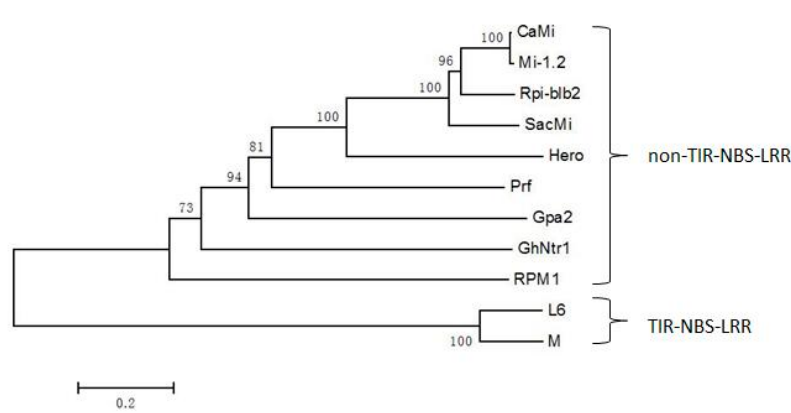
Figure 3. Phylogenetic relationships between SacMi and Mi-1.2 (AAC67238.1), CaMi (ABE68835.1), Prf (AAC49408.1), Hero (CAD29729.1), RPM1 (AGC12590.1), Rpi-blb2 (AAZ95005.1), Gpa2 (AAF04603.1), GhNTR1 (AIR09519.1), L6 (AAA91022.1), M (AAB47618.1) based on amino acid sequences.